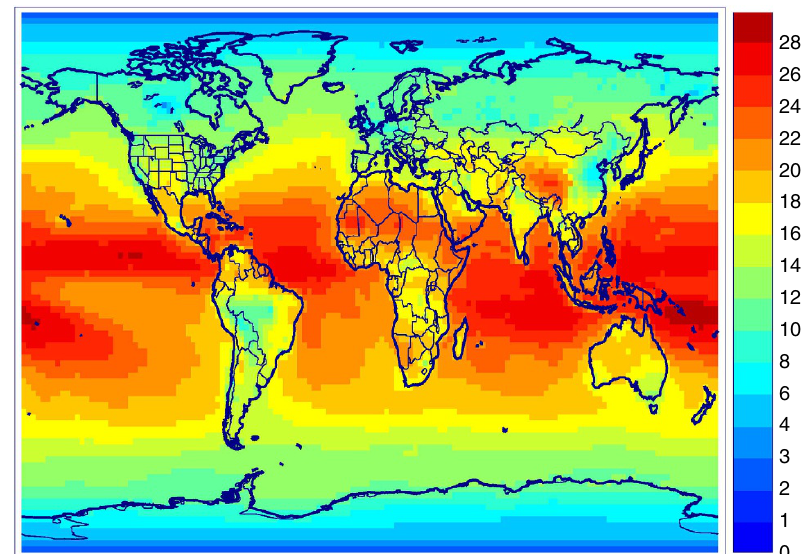
Figure 3 | Contribution of CH 3 O 2 þ OH to the sink of CH 3 O 2. Modelled yearly averaged contribution (%) of the reaction to the vertically integrated sink of CH 3 O 2 . Map created using IDL version